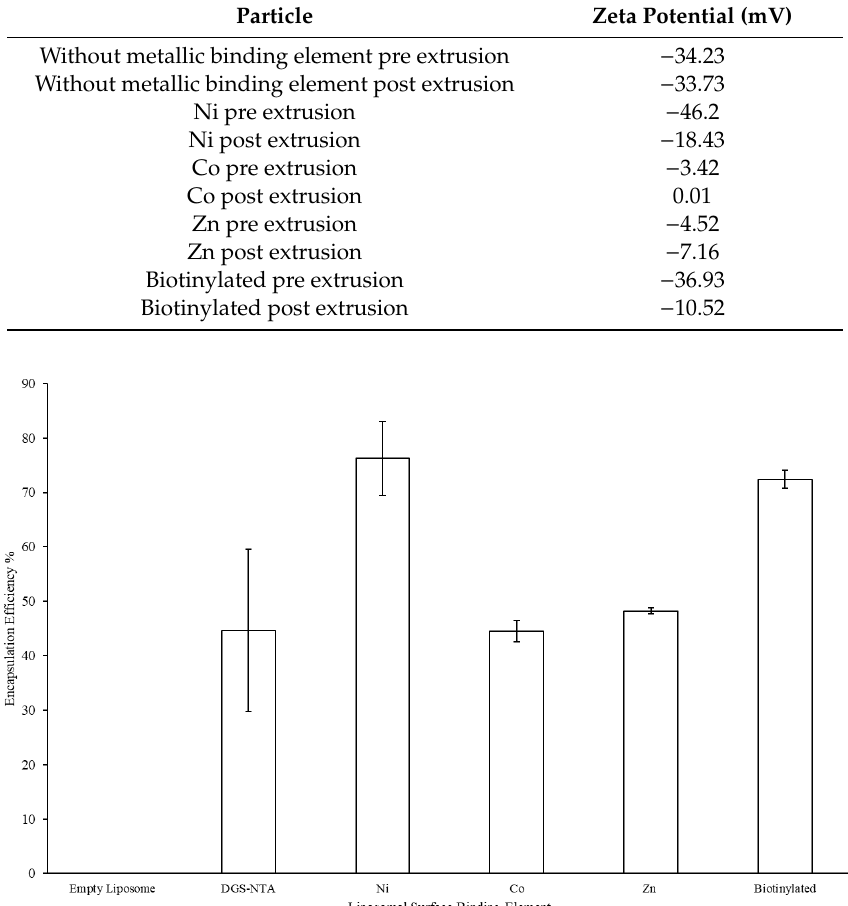
Figure 2. Size distribution analysis of empty liposomes, with closed circles representing pre-extrusion and open squares representing post-extrusion samples for liposomes without a metallic binding element (( A ) polydispersity index (PDI): 0.62 and 0.31), and with Ni (( B ) PDI: 0.32 and 0.25), Co (( C ) PDI: 0.42 and 0.74), Zn (( D ) PDI: 0.40 and 0.46), and biotinylation (( E ) PDI: 0.49 and 0.33). Table 2. Empty liposome surface charge.